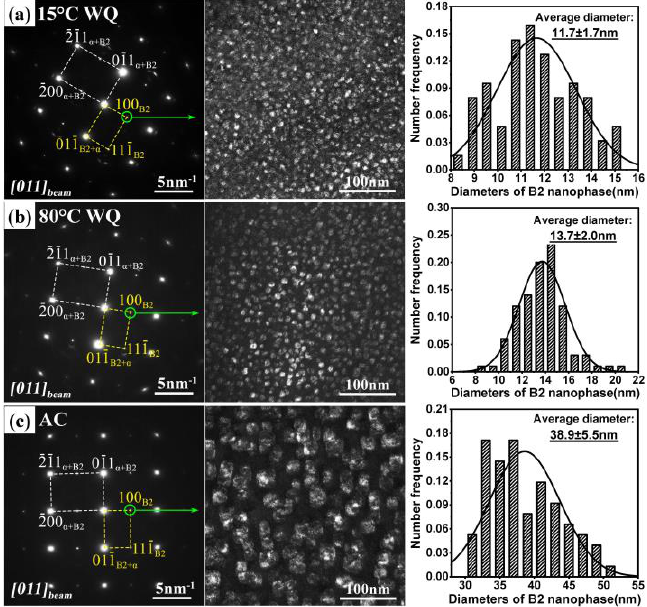
Figure 3. Electron diffraction patterns, dark field images corresponding to the {100} B2 spot, as well as the size distribution of B2 nano-particles for the solution-treated 8Ni2Mo alloy followed by 15 °C WQ ( a ), 80 °C WQ ( b ) or AC ( c ).